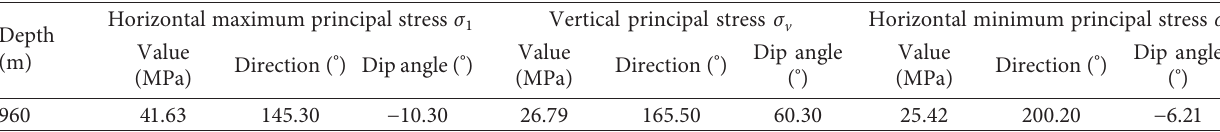
Figure 2: Flowchart of in situ stress Table 1: In situ stress measurement results at a depth of 960m.